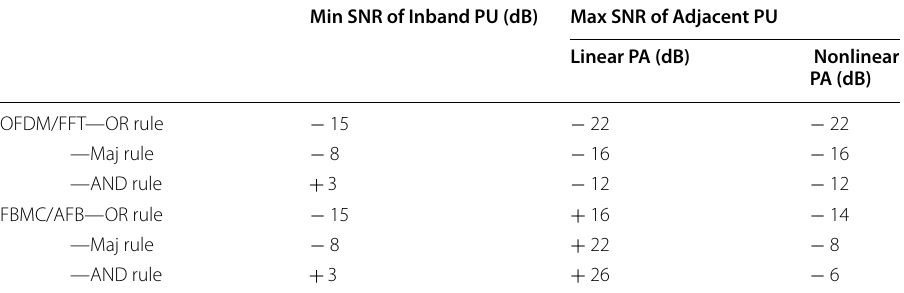
Table 1 SNR requirements for inband and adjacent channel PU SNRs for P D 0.2 and P FA ≤